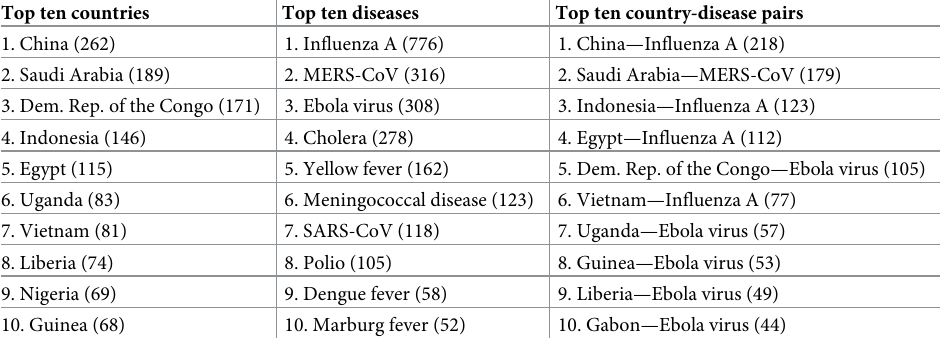
Table 1. The top reported countries, diseases, and country-disease pairs by total number of DON reports between 1996 and 2019 (number given in parentheses). Top ten countries Top ten